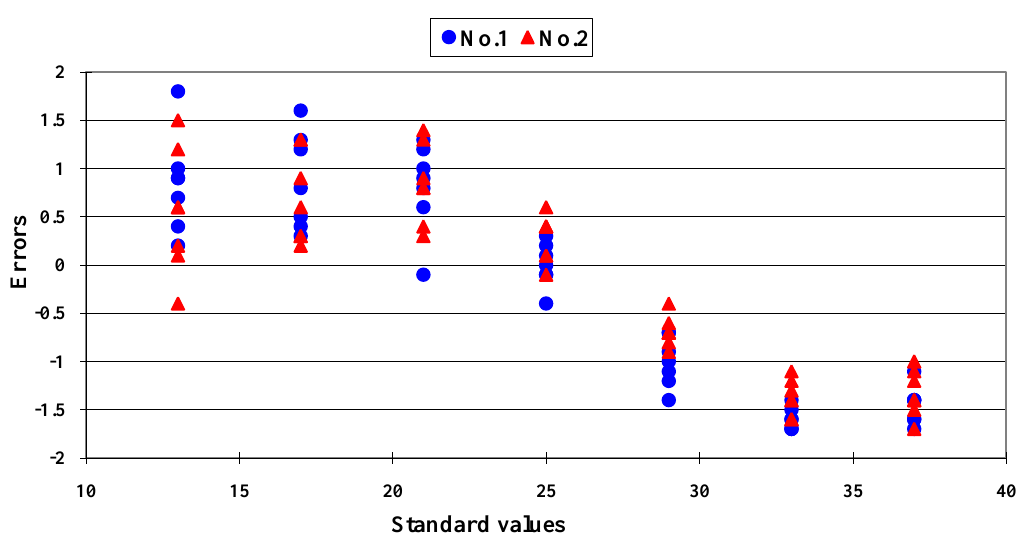
Figure 4. The errors distribution of two SENTRON SI-10A infrared thermocouples from the same manufacturer and production